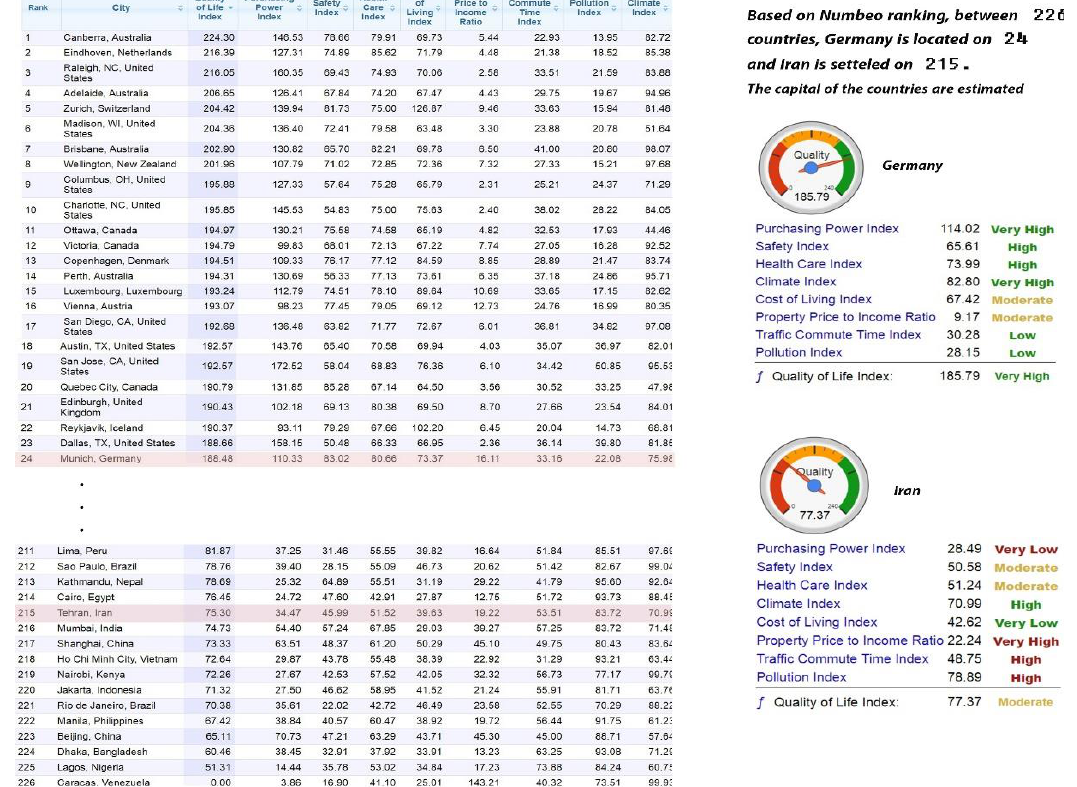
Figure 6. Quality of life and livability in Germany and Iran, 2019. (www.numbeo.com).